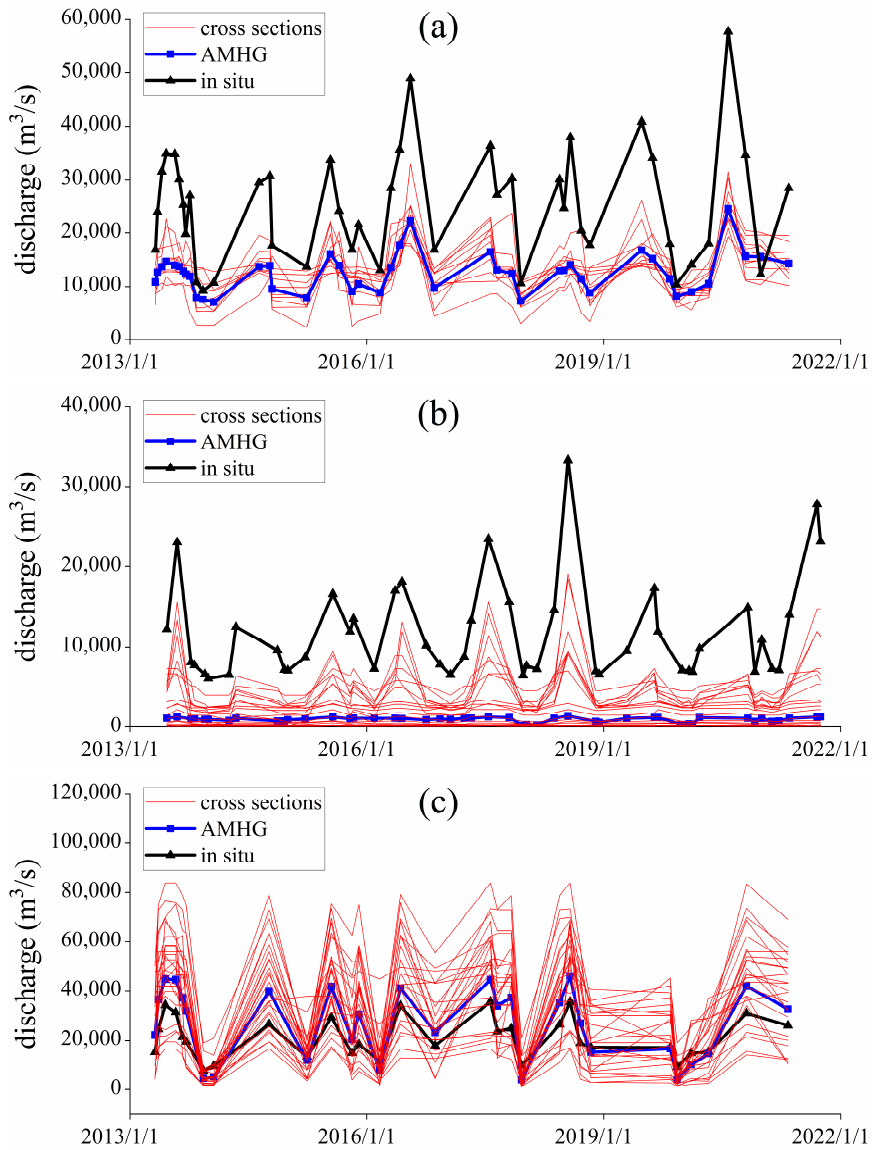
Figure 5. Discharge estimation of the original AMHG ‐ discharge ‐ retrieval method. ( a ) Results in the Hankou reach of the Yangtze River; ( b ) Results in the Shashi reach of the Yangtze River; ( c ) Results in the Luoshan reach of the Yangtze River.